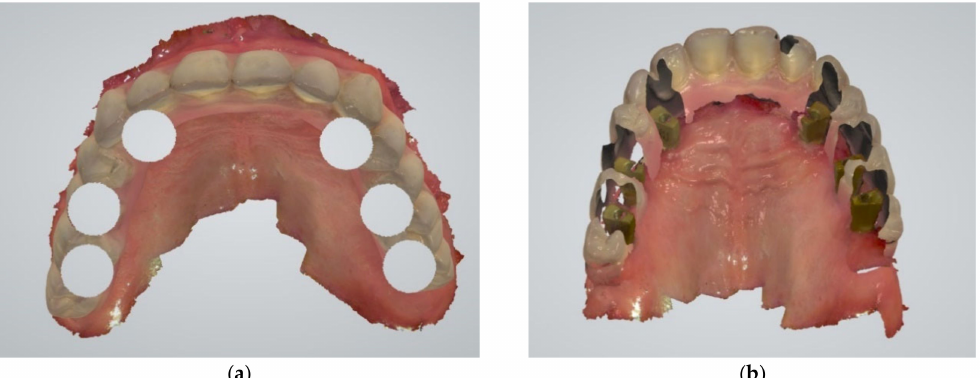
Figure 4. Subsequent to the intraoral scan of the maxillary arch with the full-arch fixed implant prosthesis: ( a ) a cut-out diameter of 6 mm was set for each implant position; ( b ) scan parts of dual-function scan bodies were installed and the maxillary scan was finalized by scanning the cut-out regions.